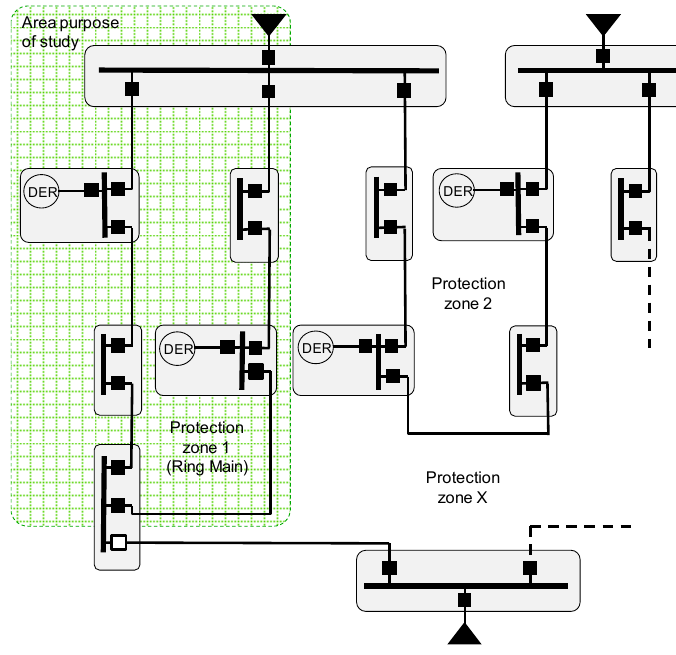
Figure 3. Electrical distribution network with DER presence.